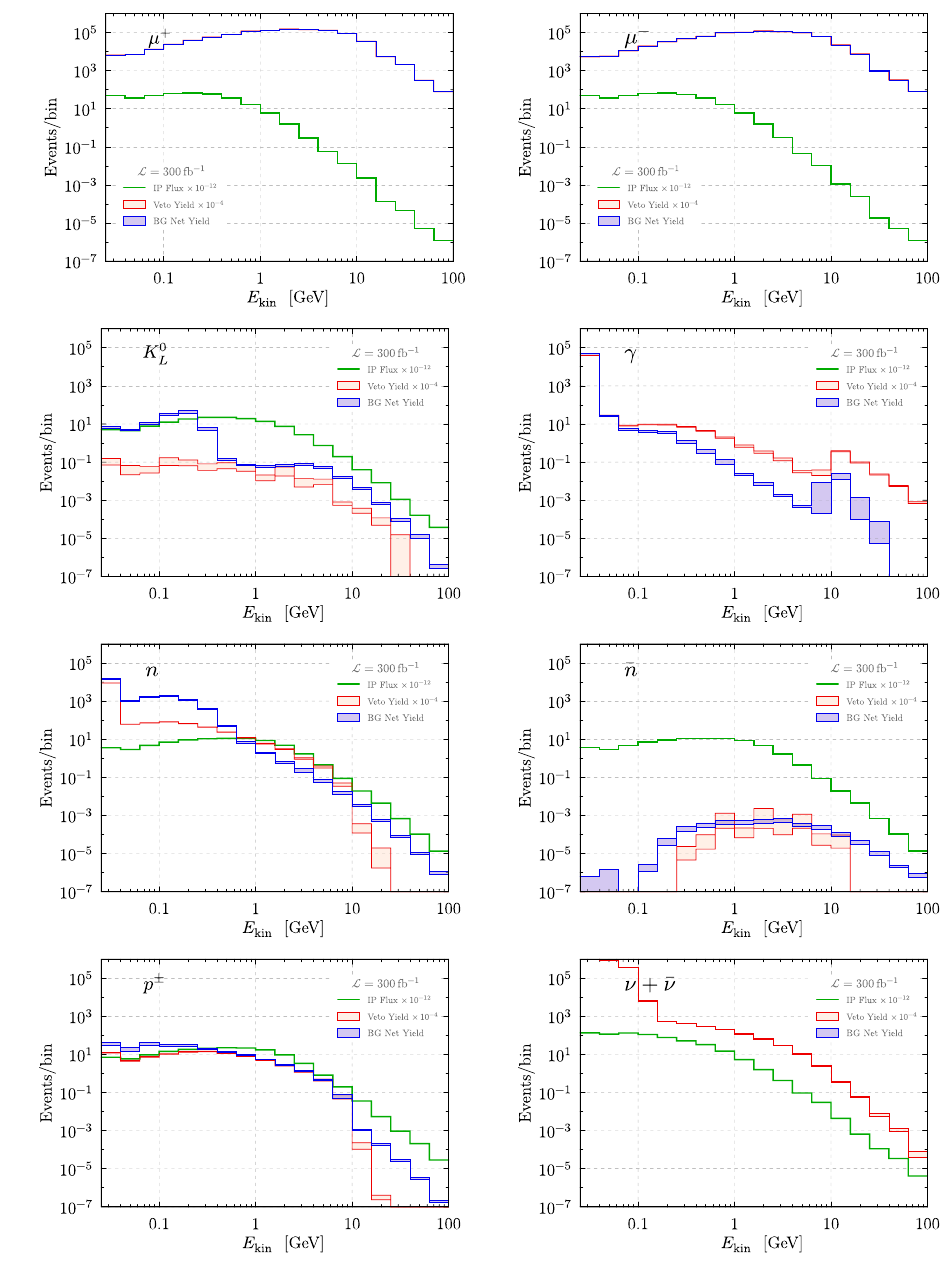
Fig. 23 Background fluxes per kinetic energy bin, comparing primary IP fluxes × 10 − 12 (green) with the irreducible background flux (blue) after the ( 20 + 5 )λ passive and active shield. Also shown are background fluxes × 10 − 4 entering the detector that are rejected by the shield veto